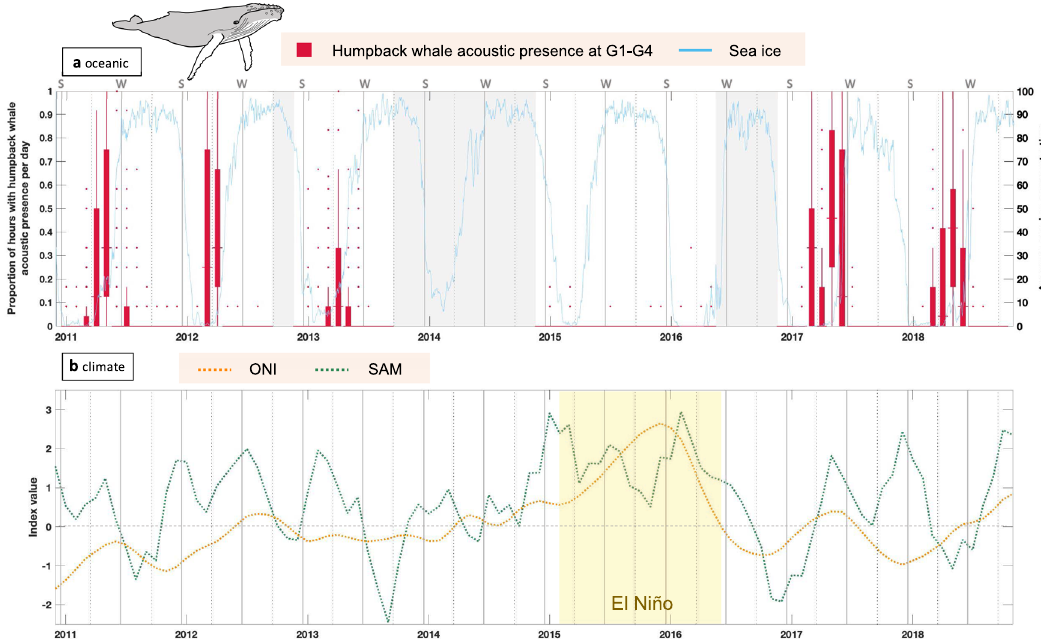
Fig. 2 Perennial humpback whale acoustic presence in relation to sea ice concentration, SAM and ONI. a Boxplot of proportion of hours per day with humpback whale acoustic presence for each month from the four oceanic recording locations (G1 – G4) on the Greenwich Meridian from December 2010 until September 2018 (red bars; n = 4614 days of recordings). Red dots represent outliers (on a discrete scale as proportion of hours per day). Gray-shaded areas represent months without recording data. The blue solid line and the right y -axis depict the daily averaged sea ice concentration within a 50 km radius around recording locations. b Climatic variations from 2011 until 2018 indicated by 3-month running means of the Southern Annular Mode index (SAM) as a dominant pattern of natural climate variability in polar and subpolar regions of the Southern Hemisphere and the Oceanic Niño Index (ONI) representing the periodic fl uctuation of sea surface temperature and air pressure originating from the tropical Paci fi c. Time span of strong El Niño phase in 2015/16 is indicated by the yellow rectangle. Vertical gray lines indicate the onset of summer (S) and winter (W) and vertical dotted lines indicate the onset of spring and autumn (based on equinoxes and solstices). Horizontal dashed line represents zero-orientation line.